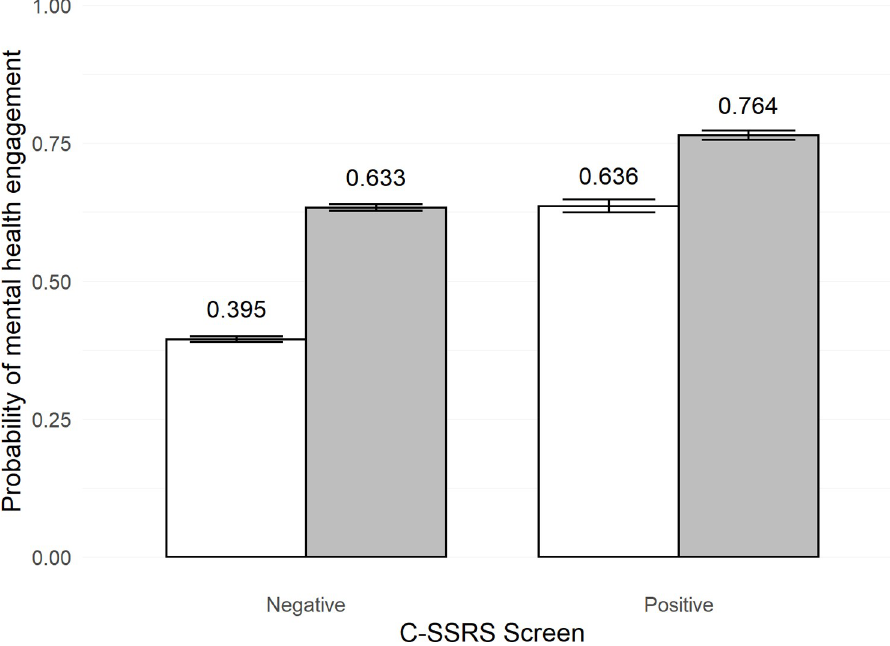
Fig 2. Probability of mental health engagement after C-SSRS screening in fiscal year 2019. The gray bars represent having received mental health treatment in past year. The white bars represent not having received mental health treatment in the past year. Error bars represent standard error. C-SSRS = Columbia-Suicide Severity Rating Scale.